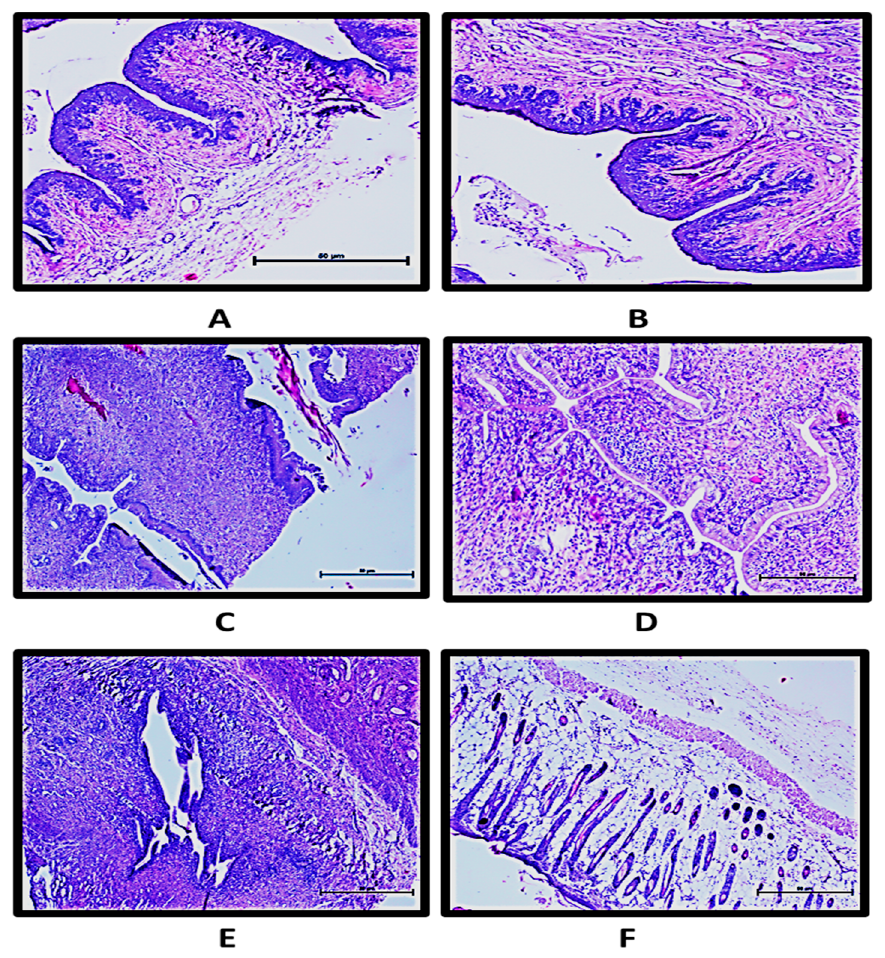
Figure 9. Histology of female reproductive tract of rat showing sections of stratified epithelial layers of ( A ) control and ( B ) treatment groups; cervix area of ( C ) control group and ( D ) treated group; ( E ) uterus of treated group; and ( F ) epithelial layer of treated group.